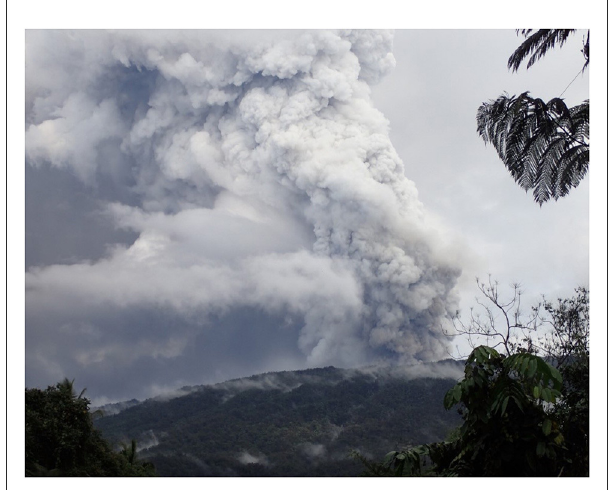
FIGURE4 Eruption of Manaro Voui Volcano, Ambae island, Vanuatu in November/December 2017. Image source: Amanda